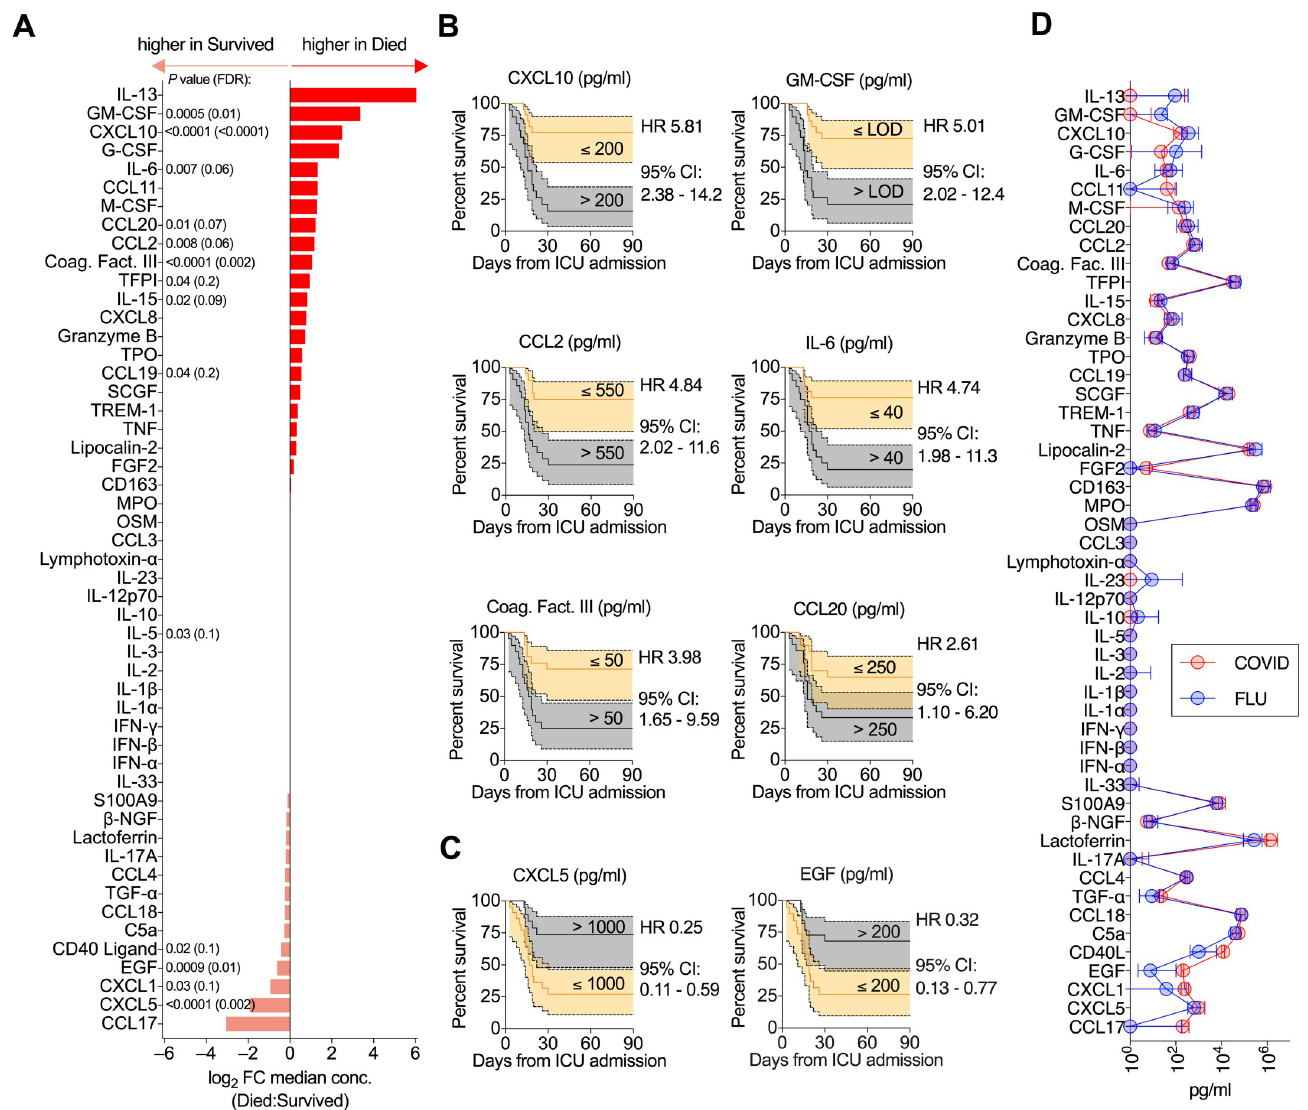
Fig 3. Mortality in critically ill COVID-19 patients is associated with perturbations in serum protein levels. (A) Fold-change in median serum protein concentration between critically ill COVID-19 patients who died versus survived. (B - C) Kaplan-Meier survival curves of critically ill COVID-19 patients based on concentration of the indicated analyte. Only proteins where FDR < 0.1 (from (A)) are plotted. (B) Kaplan-Meier survival curves for serum proteins where above median expression is associated with increased mortality. (C) Kaplan-Meier survival curves for serum proteins where above median expression is associated with decreased mortality. (D) Median serum cytokine concentration in critically ill COVID-19 patients and critically ill influenza patients. (A) Mann-Whitney U-test with Benjamini-Hochberg FDR calculation on data presented in S4A